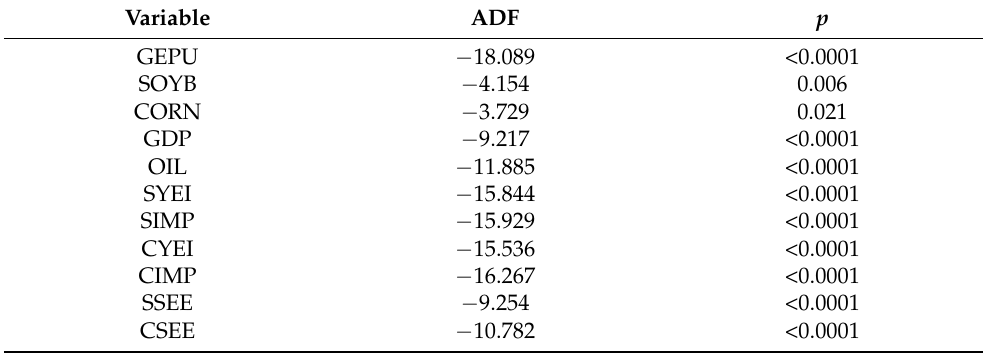
Table 1. ADF test